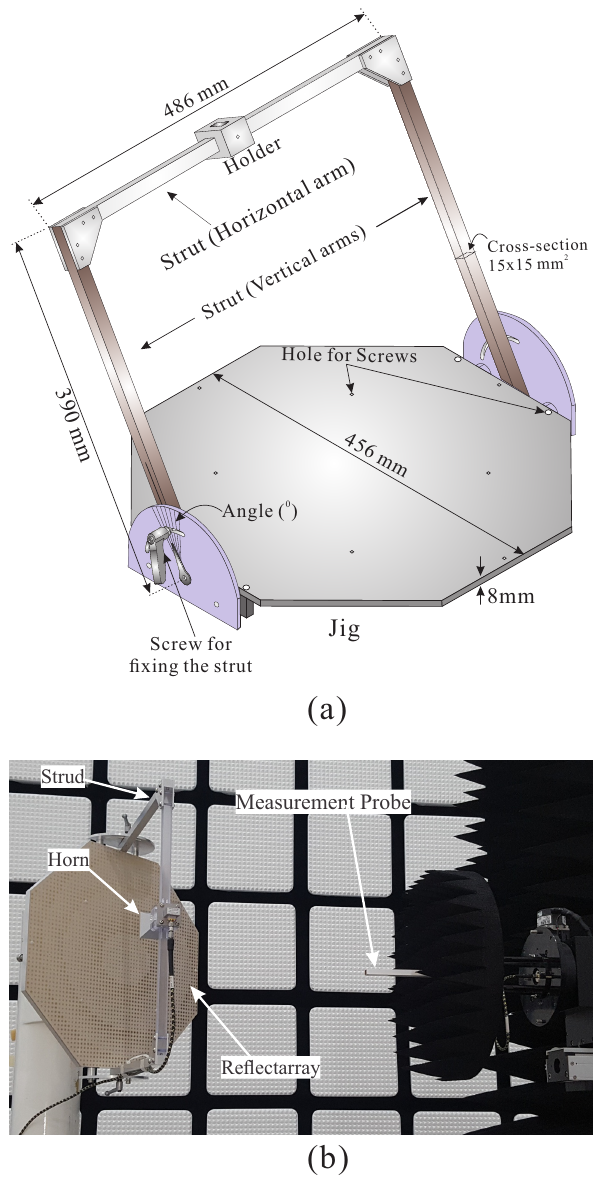
Figure 8. ( a ) Mechanical setup and ( b ) Near-field measurement setup of the proposed reflectarray. This shows that the measured peak gains of 31.2 dBi are achieved across the bandwidth. The differences in the measurements and simulations can be attributed to the fabrication tolerances and beam alignment during measurements. The RA peak aperture efficiency of 42% at 11.35 GHz is noted. Moreover, the simulated GBWs of 32% (3 dB) and 25.2% (1 dB) are